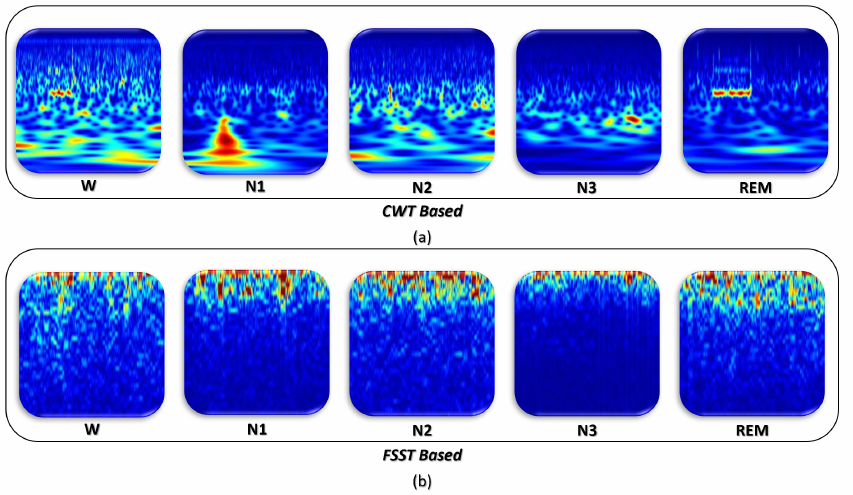
Figure 4. TF-images from 30 s EEG epochs in five different sleep stages ( a ) obtained with CWT and ( b ) obtained with